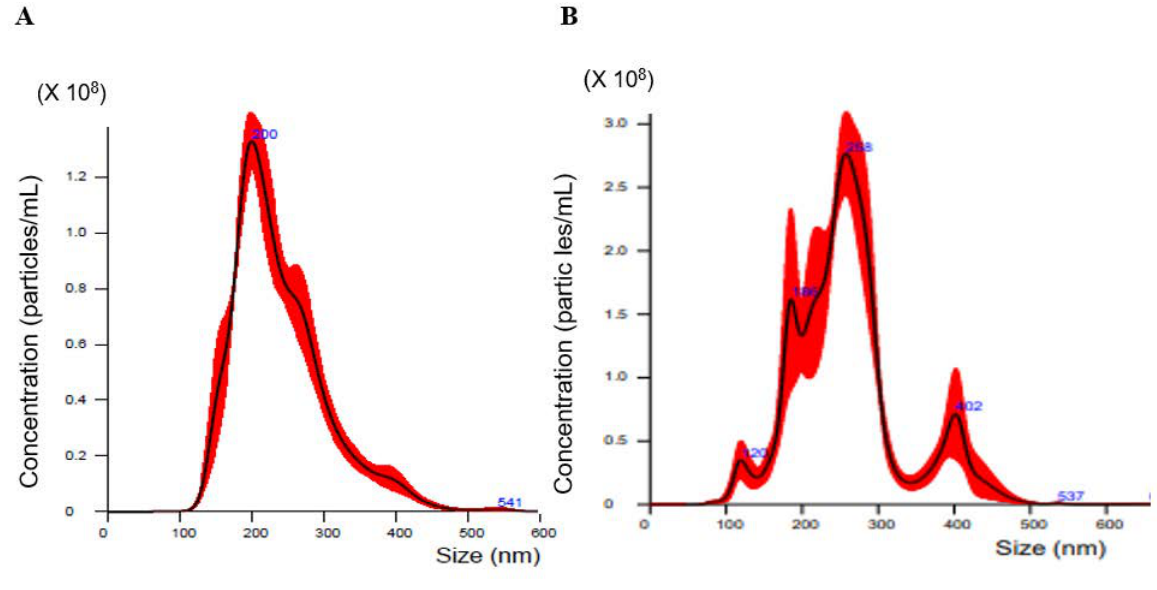
Figure 1. Nanoparticle tracking analysis (NTA) of extracellular vesicles (EVs) from ovarian cancer cell culture media. Representative particle size distribution profiles for MCAS ( A ) and HAC-2 ( B ) cells are shown.